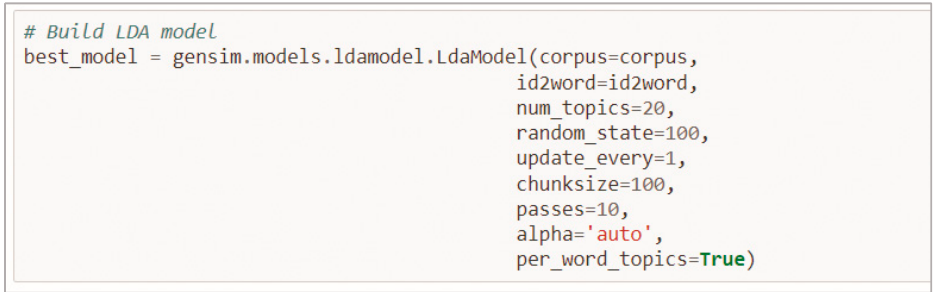
Figure 5. Code 3: Development of a Research Model, own elaboration.